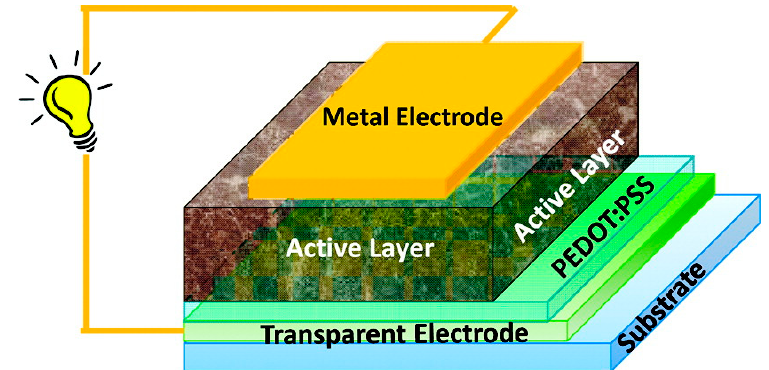
Figure 9. Structure of a typical bulk-heterojunction organic photovoltaic (OPV) cell. (reprinted from